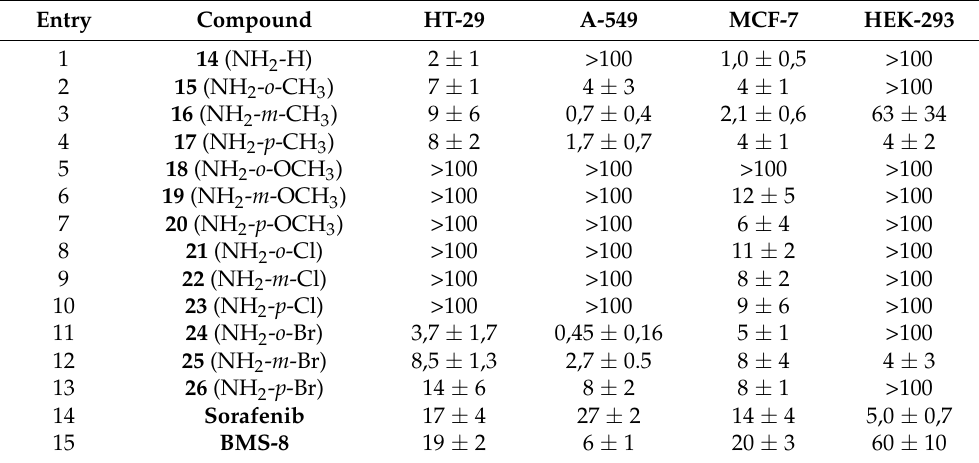
Table 1. IC 50 values ( µ M) for derivatives 14–26 , sorafenib, and BMS-8 1